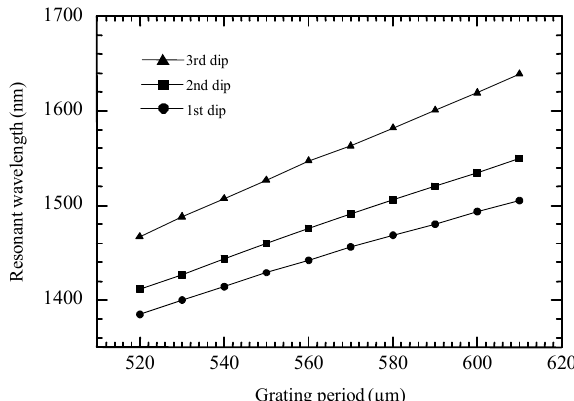
Fig. 5 Relationship between resonant wavelengths and grating periods.